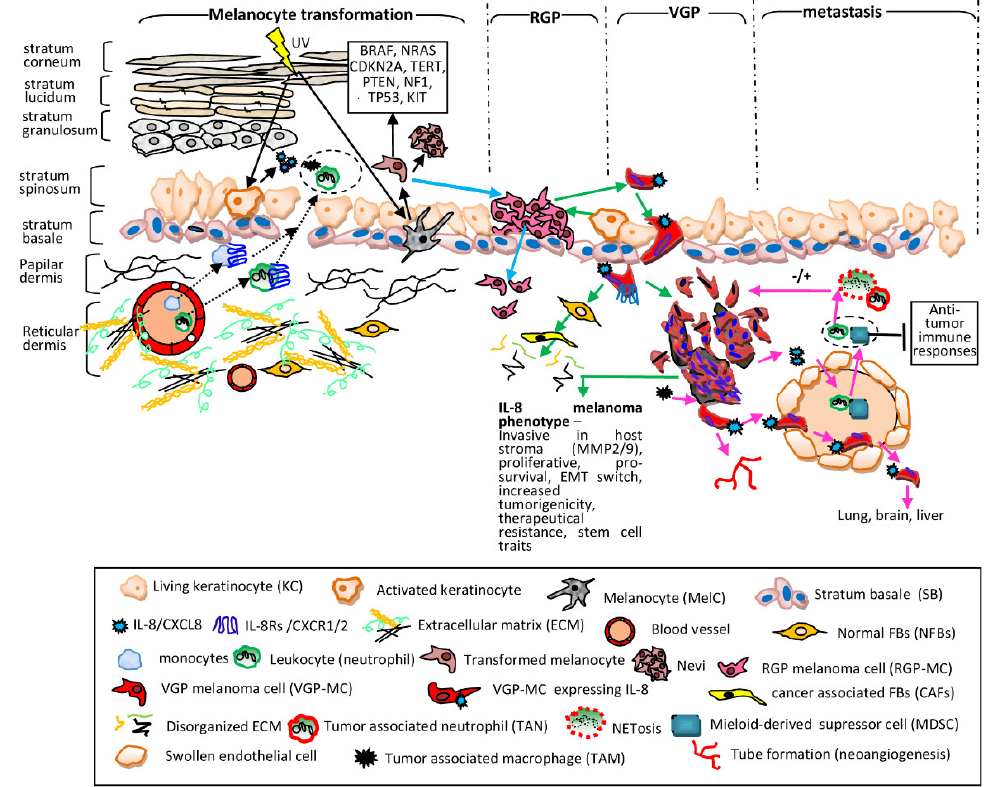
Figure 2. IL-8 contribution to melanoma progression. Melanocyte transformation (black solid ar- rows)—in KCs the UV light induces s ecretion of various CKs including IL-8 which trigger extrav- asation of monocytes and neutrophils into dermis and epidermis (black dotted arrows) creating a pro-inflammatory site (dotted circle) [124,125]. In MelCs UV increases both protective melanin synthesis and ROS generation, destructively affecting MelC genome stability; the resulting trans- formed cells have mutations (the solid line box), are highly proliferative forming benign tumors (nevi). Neither MelCs nor nevus cells express endogenously IL-8. Radial growth phase (RGP) (blue arrows)—transformed cells proliferate along SB, forming a patch in the skin. The RGP-MCs invade dermis; however, they cannot form a tumor mass. The RGP-stage is generally associated with be- nignity and RGP-specimens still do not express IL-8. Vertical growth phase (VGP) and IL-8 phe- notype (green arrows)—activated KCs together with hypoxia conditions and pro-inflammatory CyKs (IL-1 α, IL-1β, TNF-α) trigger IL-8 expression in RGP-MCs. They switch the molecular rep- ertoire, activate processes which allow them to protrude beyond the SB and acquire IL-8 expression [103]. The MCs inhibitory motility signals are downregulated; MCs become invasive into papillary and reticular dermis, being actively involved in the transformation of NFBs into CAFs; CAFs in- crease melanoma invasiveness and ECM degradation. MCs expressing IL-8/IL-8Rs grow intensely due to autocrine/paracrine signals, attach to degraded ECM with overexpressed integrins and mi-